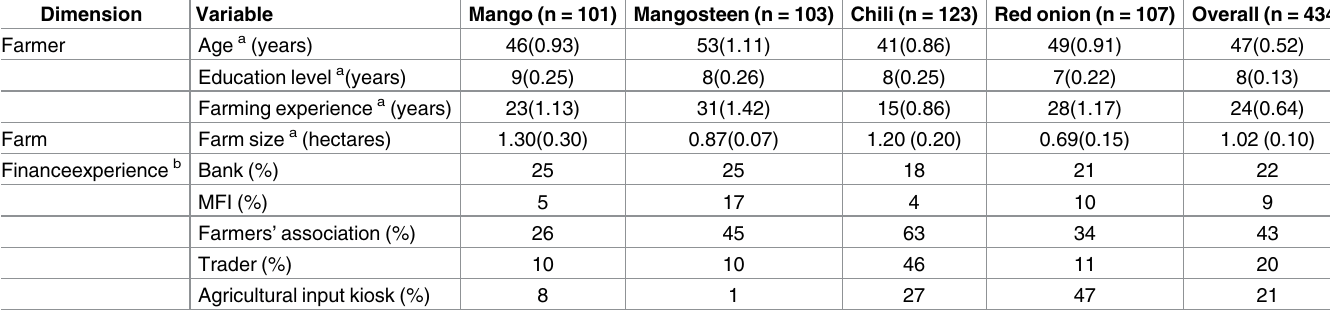
Table 1. Demographic and socioeconomic characteristics of farms in the